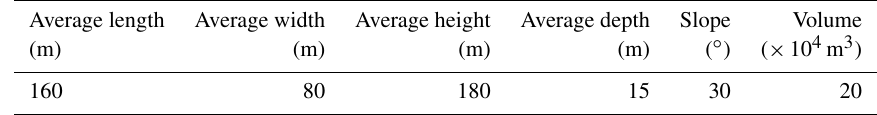
Table 1. The landslide 3-D characteristics induced by the earthquake in the study area.